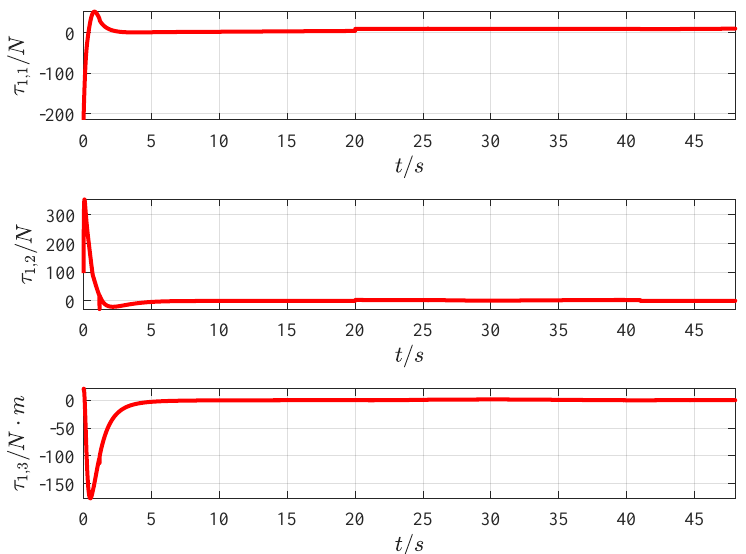
Figure 11. Position tracking of triangular formation of USVs.